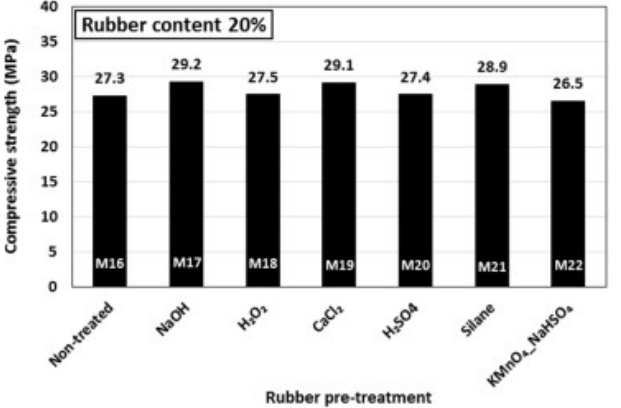
Figure 11. Effects of rubber pretreatment on rubberized concrete strength [6].